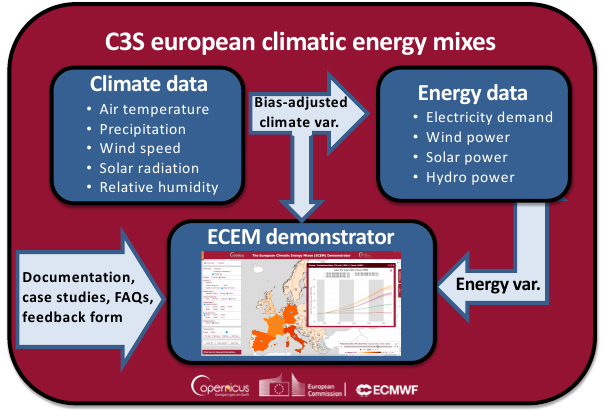
Figure 1. Overview of the C3S ECEM project. Climate data of rel- evance to the energy sector (top left) are first bias -adjusted and then converted into energy variables through statistical modelling or transfer functions. Climate and energy variables (var.) produced by the C3S ECEM are presented via the Demonstrator (inset fig- ure expanded as Fig. 2) together with a wide range if documenta- tion. For more information, see: http://ecem.climate.copernicus.eu/ demonstrator/ (last access: 3 July